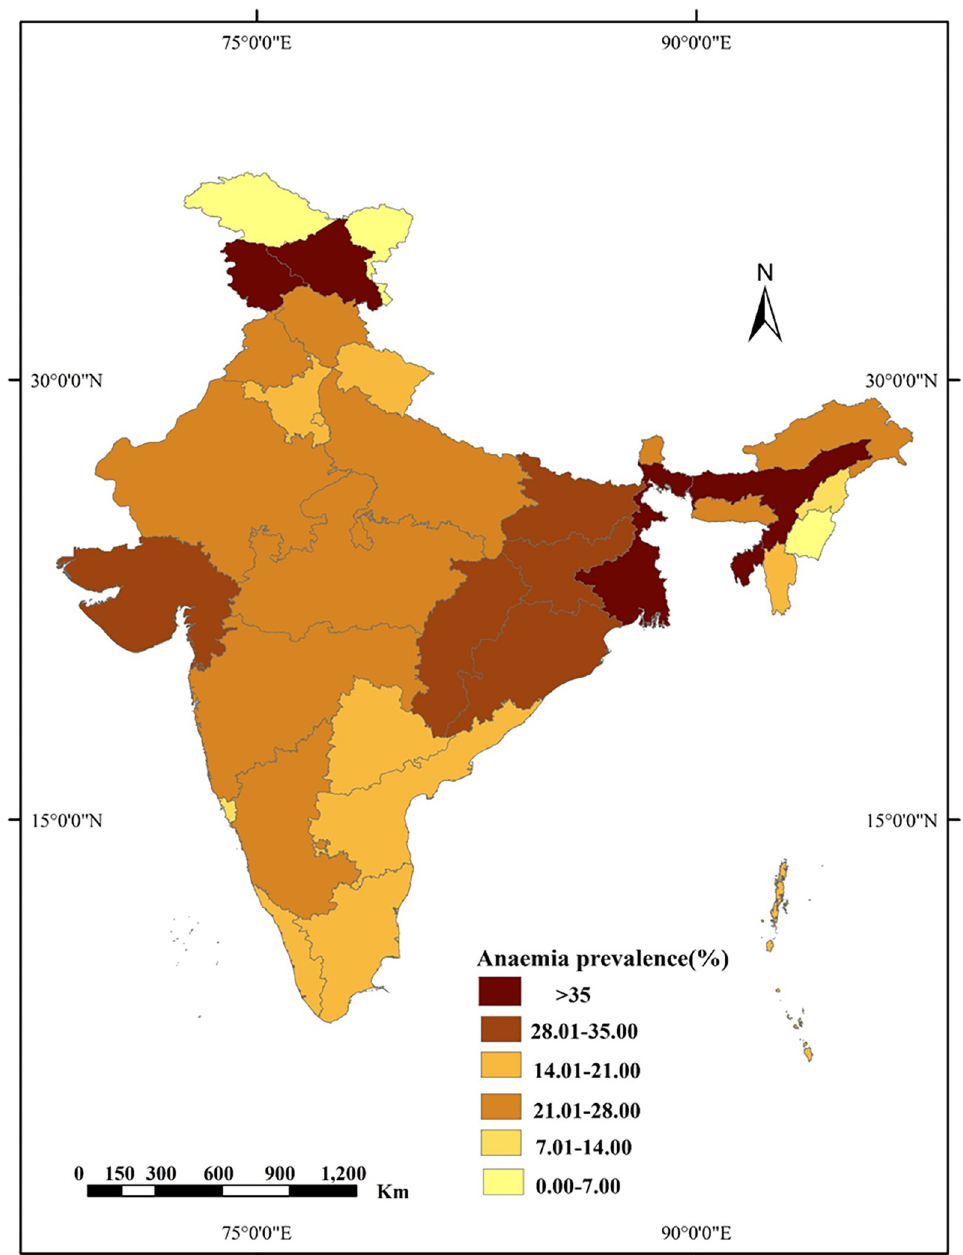
Fig 4. Map showing state wise prevalence anaemia among rural men in India, NFHS-5, 2019–21. (All the maps used are the authors’ own creations. As far as the base layer is concerned, we used a free GIS file from https://spatialdata. dhsprogram.com/boundaries/#view=table&countryId=IA for national and sub-national boundaries).